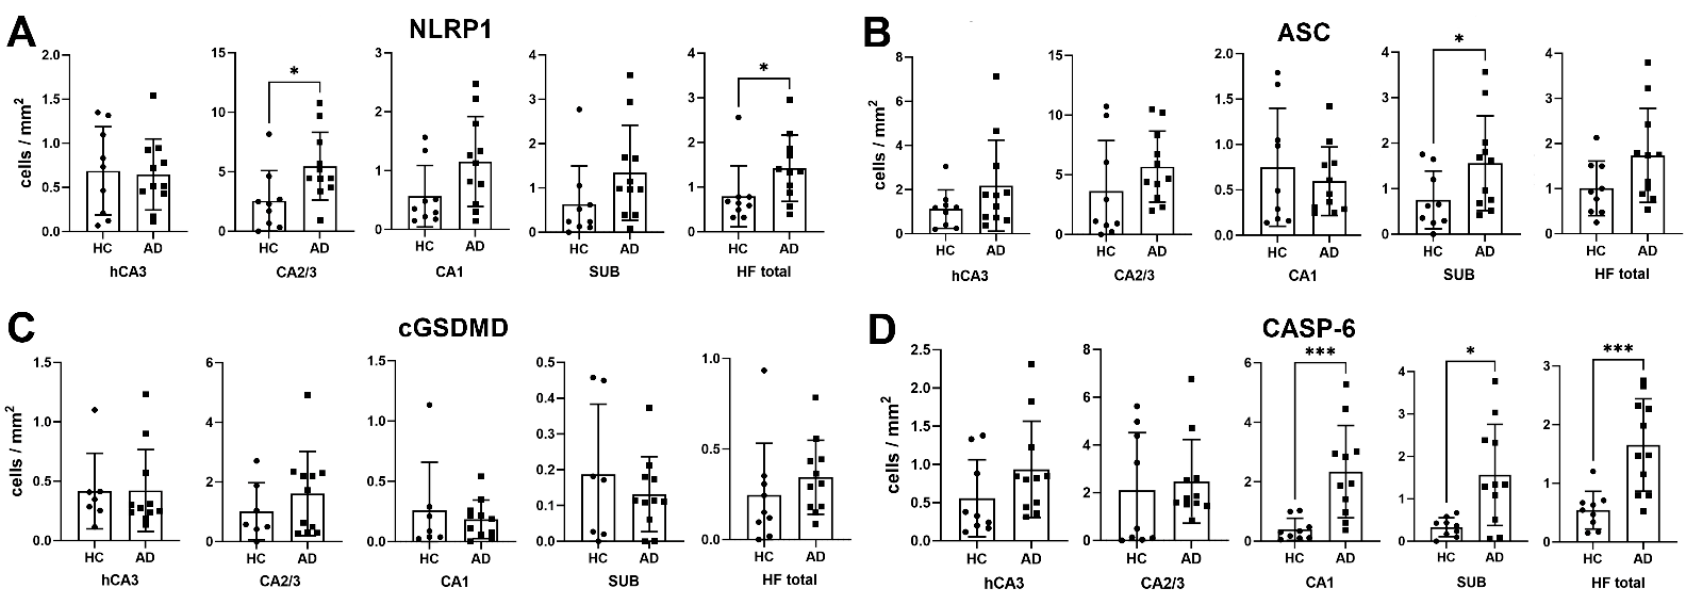
Figure 1. The regional density of immunoreactive neurons for NLRP1 ( A ), ASC ( B ), cGSDMD ( C ), and CASP-6 ( D ). ( A ) Compared to HC, a significantly higher quantity of NLRP1-labeled cells was found in the CA2/3 field in the AD group ( p = 0.02). Although individual comparisons of hCA3, CA1, and SUB were not significant ( p = 0.88, p = 0.11, and p = 0.07, respectively), when the hippocampal formation (HF) was viewed as a whole, the difference in the quantity of NLRP1-labeled cells was statistically significant ( p = 0.03). ( B ) Compared to HC, a significantly higher quantity of ASC-labeled cells was found in the SUB in the AD group ( p = 0.04). Other individual comparisons of ASC-labeled cells in the hCA3, CA2/3, and CA1 fields were not significant ( p = 0.18, p = 0.13, and p = 0.99, respectively) as was the hippocampal formation (HF) viewed as a whole ( p = 0.07). ( C ) Regarding cGSDMD, in the AD group neither the hCA3, CA2/3, CA1, and subiculum were significantly different from HC ( p = 0.6, p = 0.54, p = 0.79, p = 0.72, respectively) nor was the hippocampal formation (HF) viewed as a whole ( p = 0.15). ( D ) Regarding CASP-6 labeling, a significantly higher quantity of labeled cells was found in the CA1 and subiculum in the AD group compared to HC ( p = 0.0005 and 0.02, respectively). Comparisons of hCA3 and CA2/3 were not significant ( p = 0.13 and p = 0.41, respectively). When the hippocampal formation (HF) is viewed as a whole, the difference was highly significant ( p = 0.0008). * = p < 0.05, *** = p < 0.001.